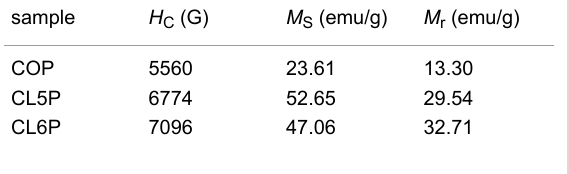
Table 3: Coercivity, saturation magnetization and remanence of PANI/barium hexaferrite. sample